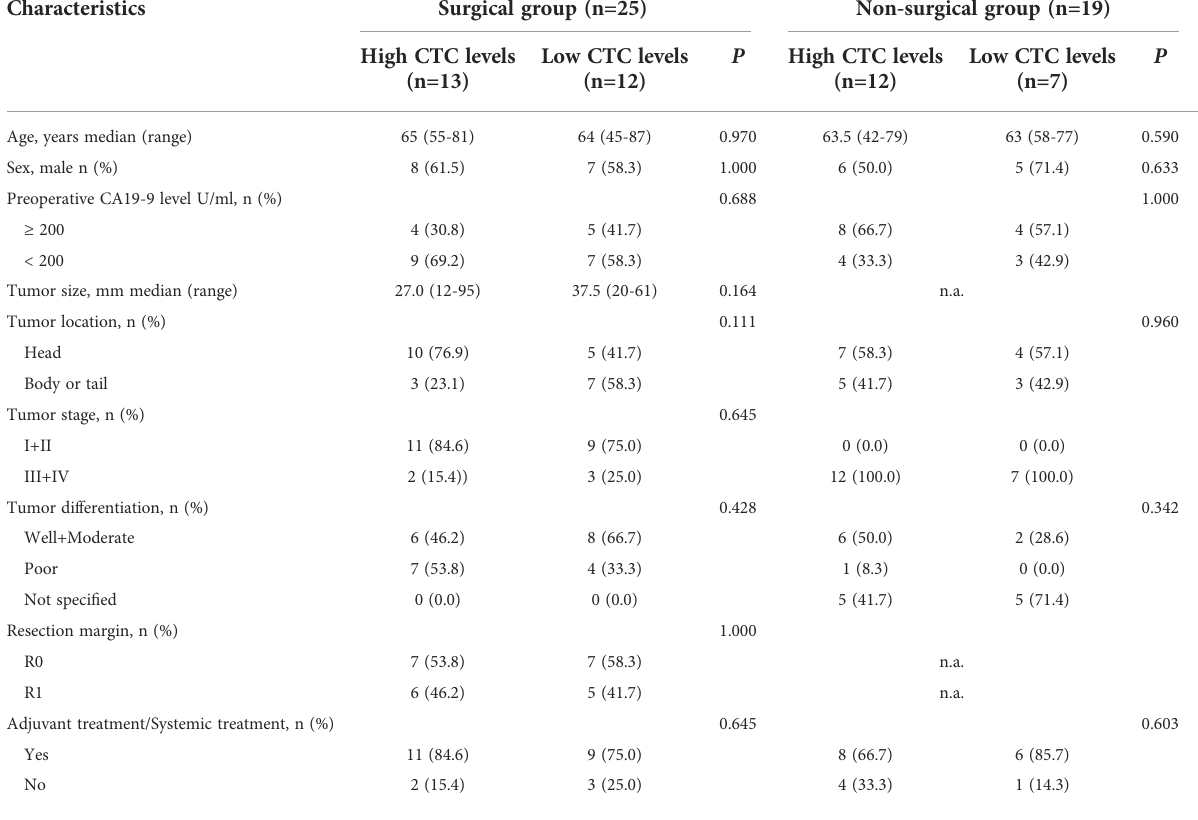
TABLE 2 Comparison of the clinicopathological characteristics of patients with high and low CTC levels in different groups.